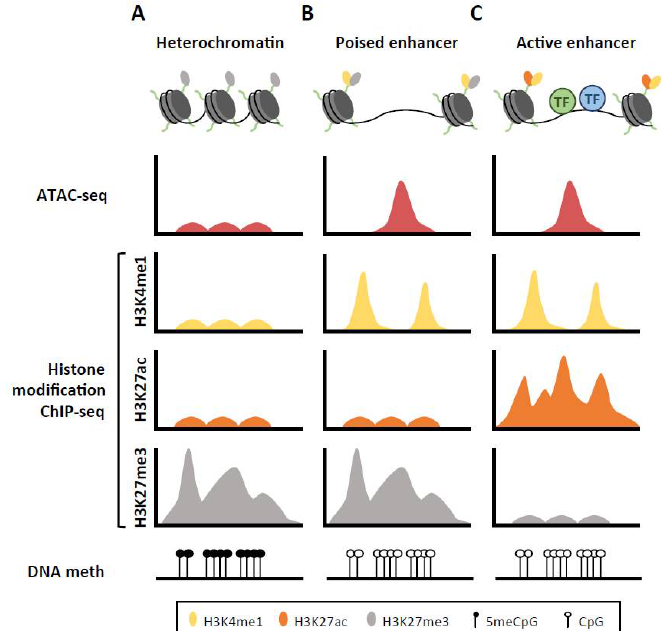
Figure 1. Chromatin landscape for heterochromatin, poised and active enhancer regions. ( A ) The inactive DNA is tightly packed around histone proteins marked with H3K27me3 modification, in the form of heterochromatin. This structure prevents any interactions between transcription factors (TF) and the DNA sequence. ( B ) When the enhancer region is preactivated or poised, addition of H3K4me1 to the histone tails make the nucleosomes mobile, allowing for their displacement to form highly accessible DNA regions, which get frequently demethylated. ( C ) Upon activation of enhancer region, nucleosomes flanking this region acquire H3K27ac, losing the repressing H3K27me3 mark, which subsequently recruits the corresponding transcription factors.